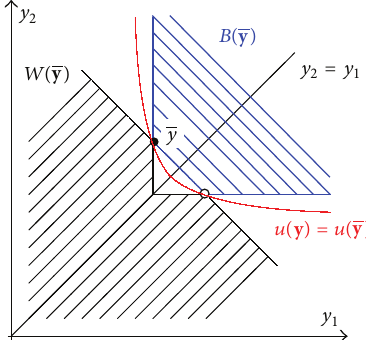
Figure 1: The fair dominance structures 𝑊( y ) : the set of outcomes fairlydominatedby y and 𝐵( y ) :thesetofoutcomesfairlydominating y